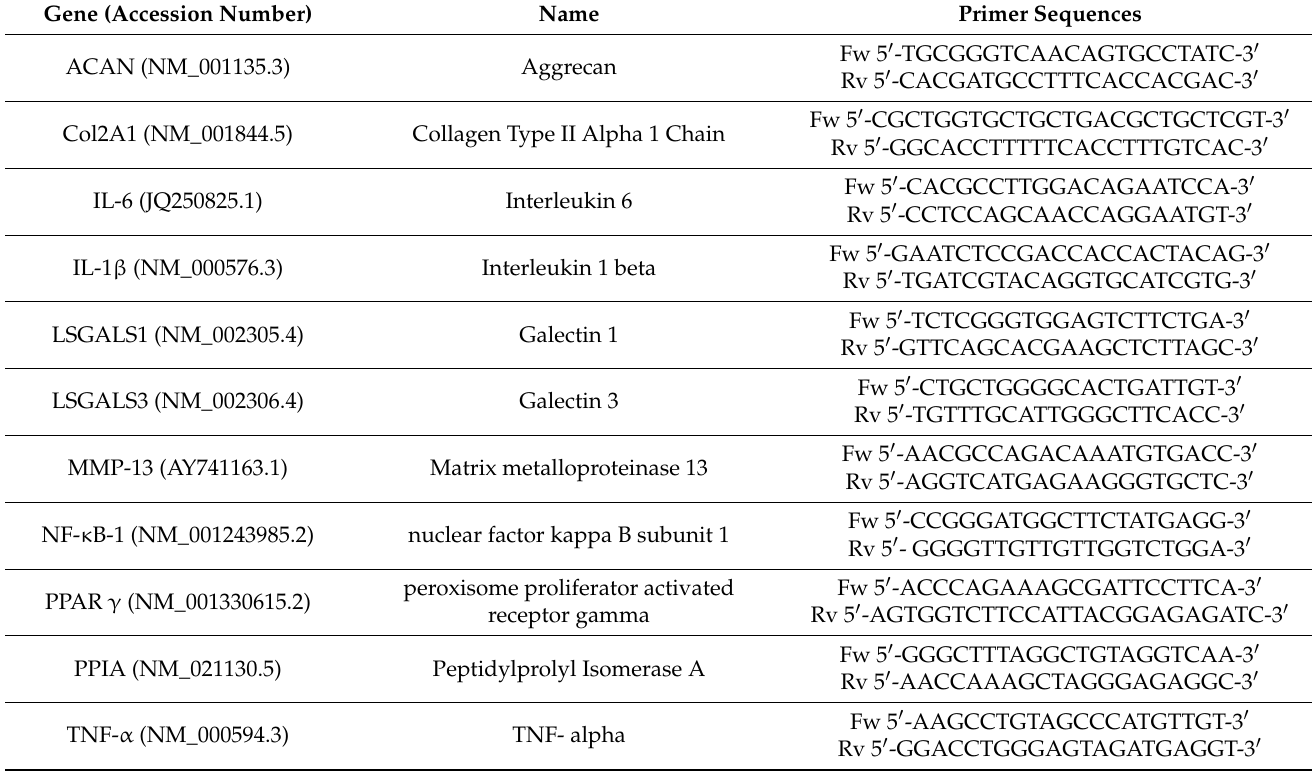
Table 1. Genes investigated and primers